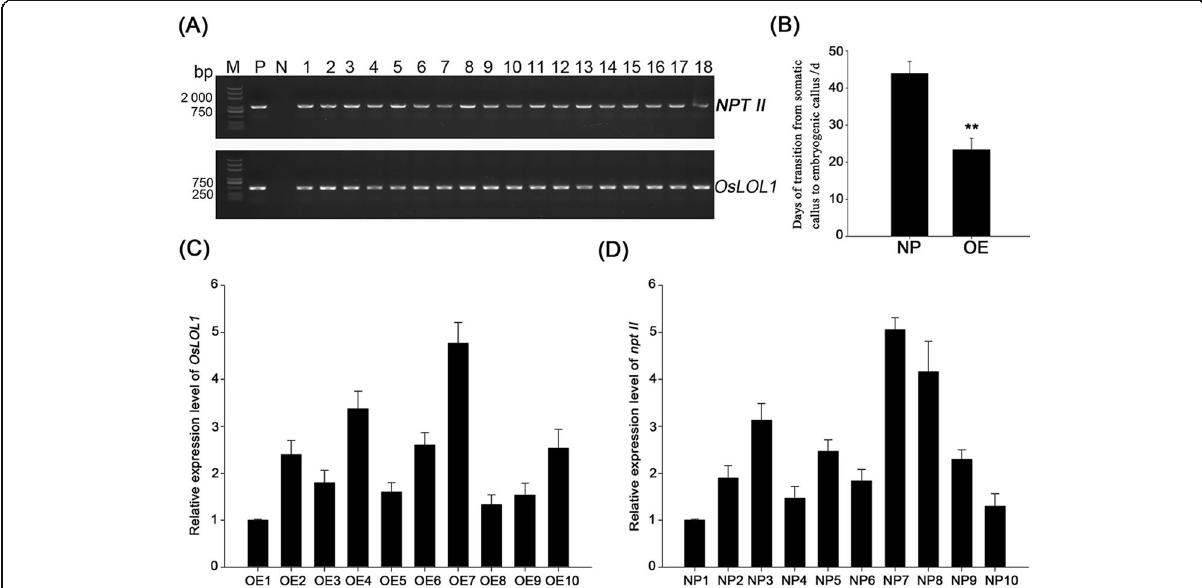
Fig. 1 Development of transgenic cotton embryogenic calli with OsLOL1 overexpression and empty vector. a PCR detection of transgenic cotton embryogenic calli. M: DNA marker; P: positive control, the plasmid with OsLOL1 gene; N: non-transgenic cotton plants; 1 – 18: various independent embryogenic calli. b Days of transition from somatic callus to embryogenic callus. NP: samples with empty vector, OE: those with OsLOL1. Bar values (SD) are calculated through three biological repeats. Double asterisks represent extremely significant differences ( P < 0.01) by Student ’ s t - test. c and d Relative expression levels of OsLOL1 ( c ) and NPT II ( d ). OE1 – 10: those with OsLOL1 overexpression, NP1 – 10: the embryogenic calli with empty vector. GhUbi gene was used as internal control for normalization. The expression levels of OE1 and NP1 are arbitrarily regarded as “ 1 ” , respectively. Bars represent SD from biological repeats